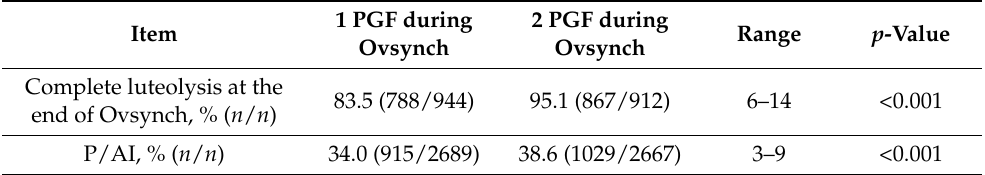
Table 3. Effect of an additional treatment with prostaglandin F2 α (PGF) during the Ovsynch protocol on complete luteolysis at the end of the protocol and on pregnancy per artificial insemination